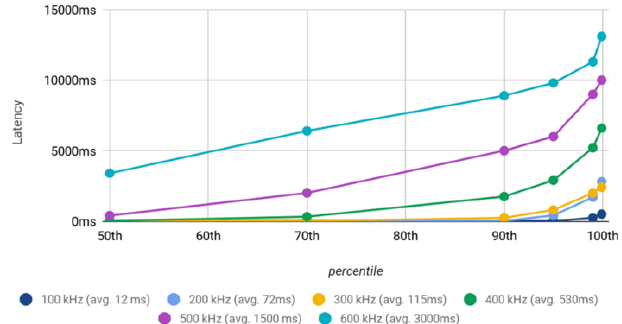
Fig. 3. Latency, defined as the difference between the production and storage times, as a function of the metric percentile for different metric rates